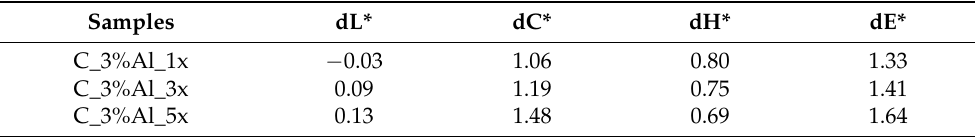
Table 6. Change in color coordinates of the cotton sample treated with 3% Al mordants after 1st, 3rd and 5th washing cycle (compared with